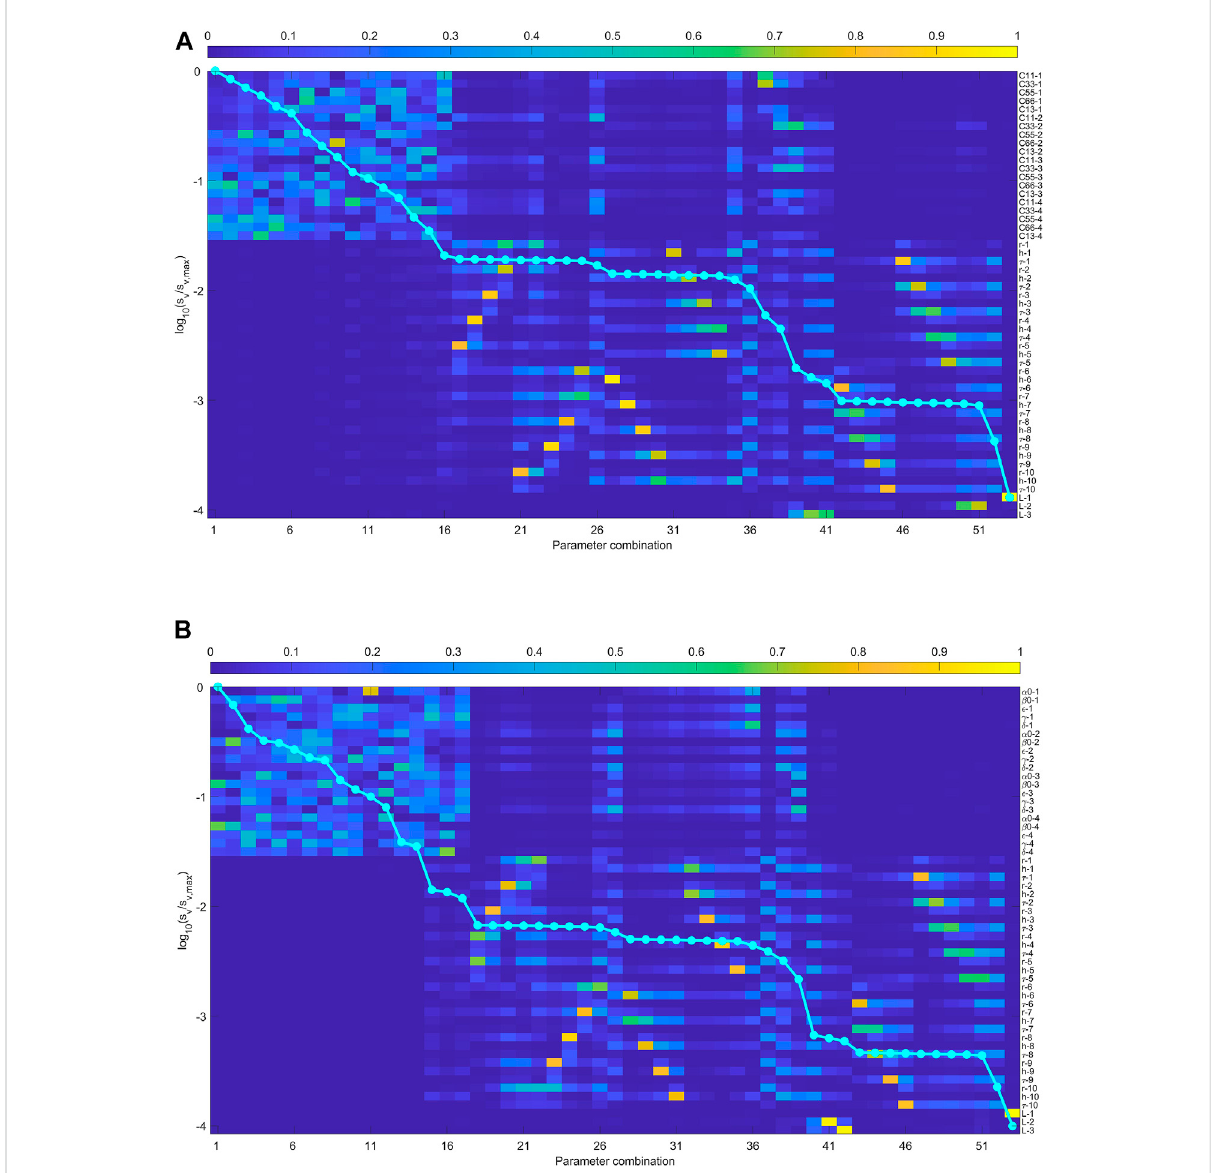
FIGURE 4 (A) The sensitivity analysis of the joint inversion using the arrival times of qP wave and two S- waves. The anisotropic is represented by c ij parametrization. (B) the rows of eigenvector matrix are sorted to make it diagonally dominant as possible. The absence of singular values close to zero means all the parameters on the right contribute to the observed